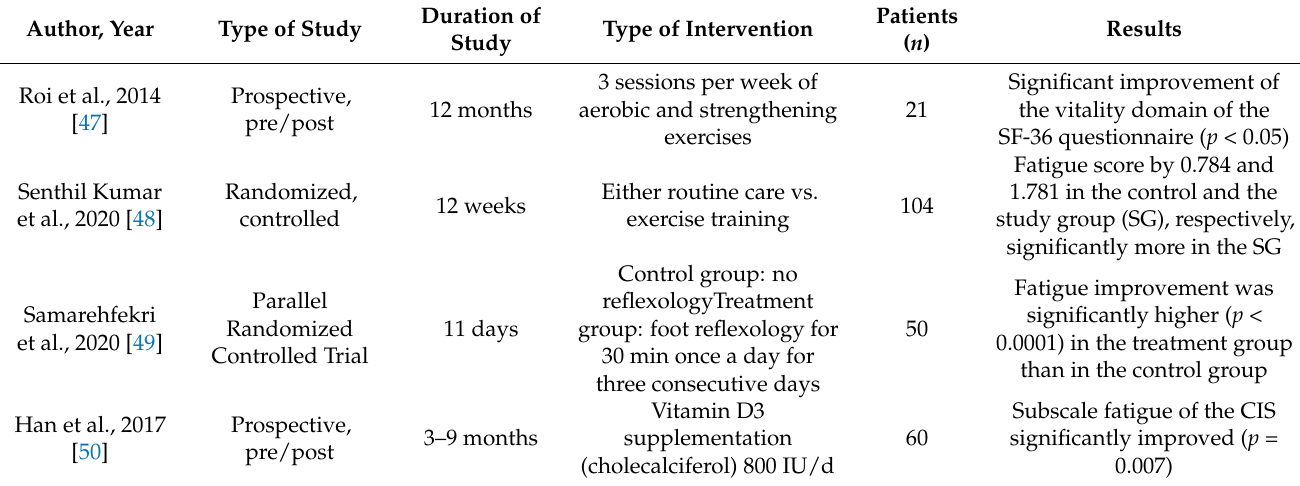
Table 4. Treatment of fatigue in KTR. CIS, Checklist Individual